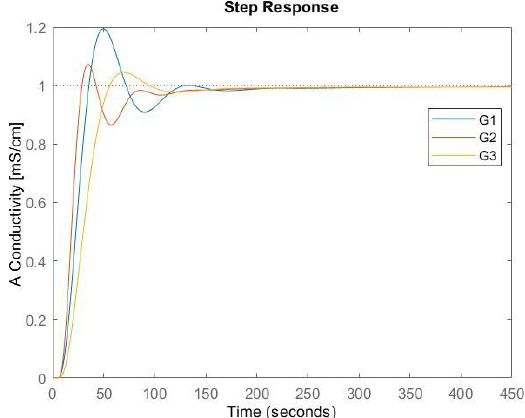
Figure 12. Bode diagram of the open-loop system for the third designed FO-PID controller.